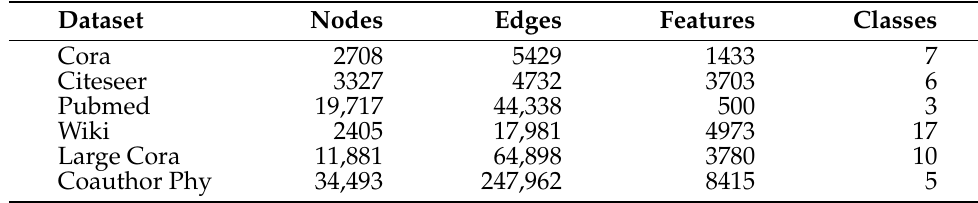
Table 1. The statistics of